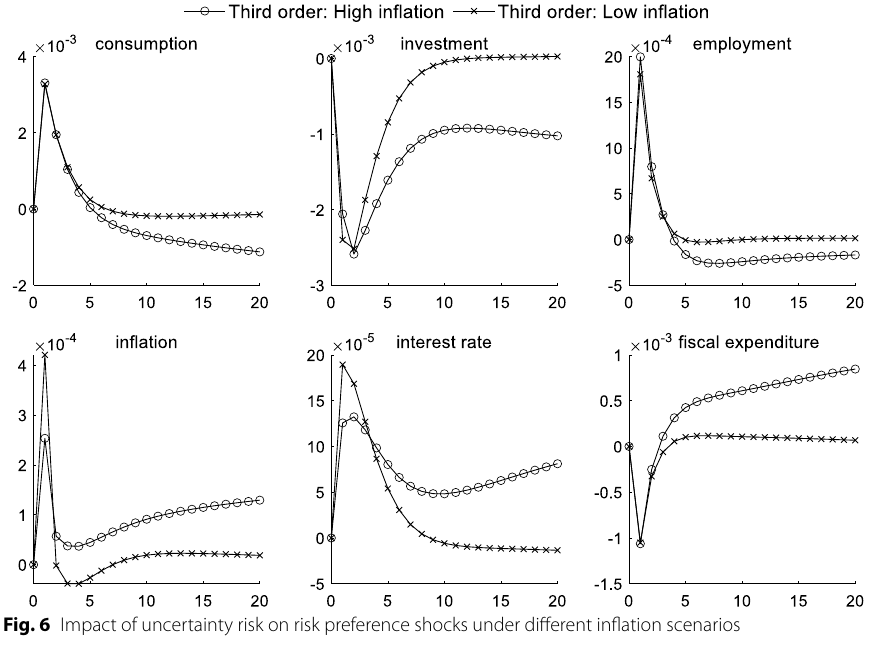
Fig. 6 Impact of uncertainty risk on risk preference shocks under different inflation scenarios